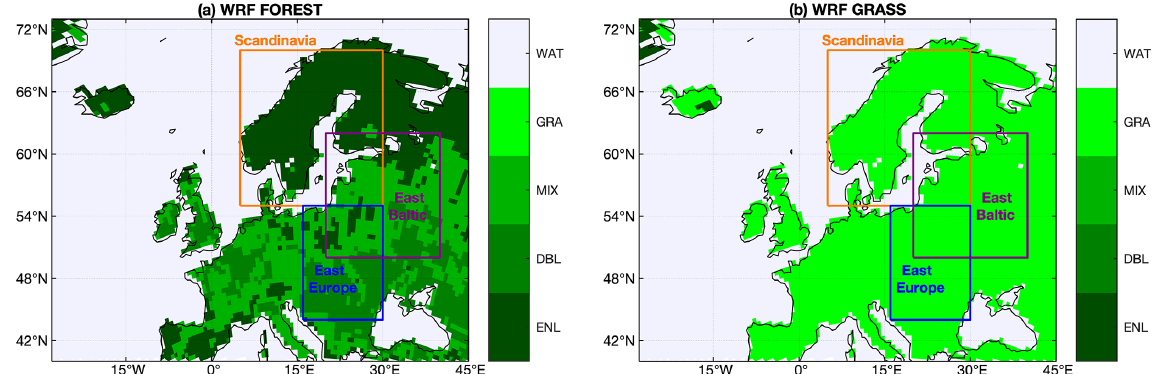
Figure 1. The three regions considered in the analysis: Scandinavia, East Baltic, and East Europe. Also shown are the land cover maps for the FOREST and GRASS experiments. The colour bars indicate land cover type where WAT means water, GRA means grass, MIX means mixed forests, DBL means deciduous broadleaf, and ENL means evergreen